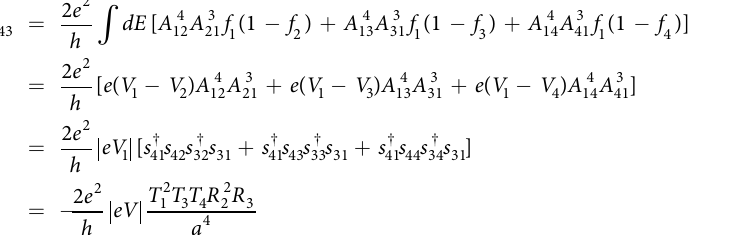
probe (contacts 1 and 3) case is zero. The nonlocal HBT correlation is negative which is the property of the Fermi-Dirac distribution which directly relates to the antisymmetric wave function of electrons.